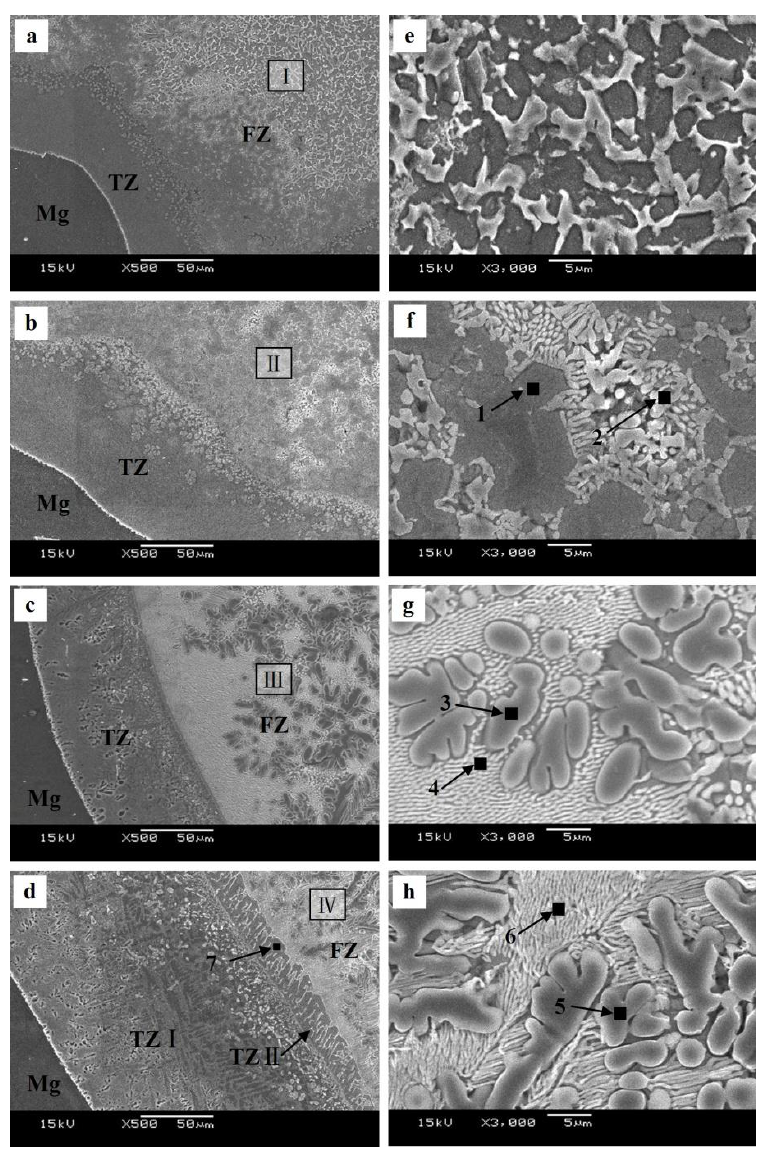
Figure 6. Microstructures of the welded joint in Area I: ( a , b , c and d ) the microstructure of Area I using Zn–10Al, Zn–20Al, Zn–30Al and Zn–40Al as the filler metals, respectively; ( e , f , g and h ) the magnifications of I, II, II and IV from ( a ), ( b ), ( c ) and ( d ), respectively.